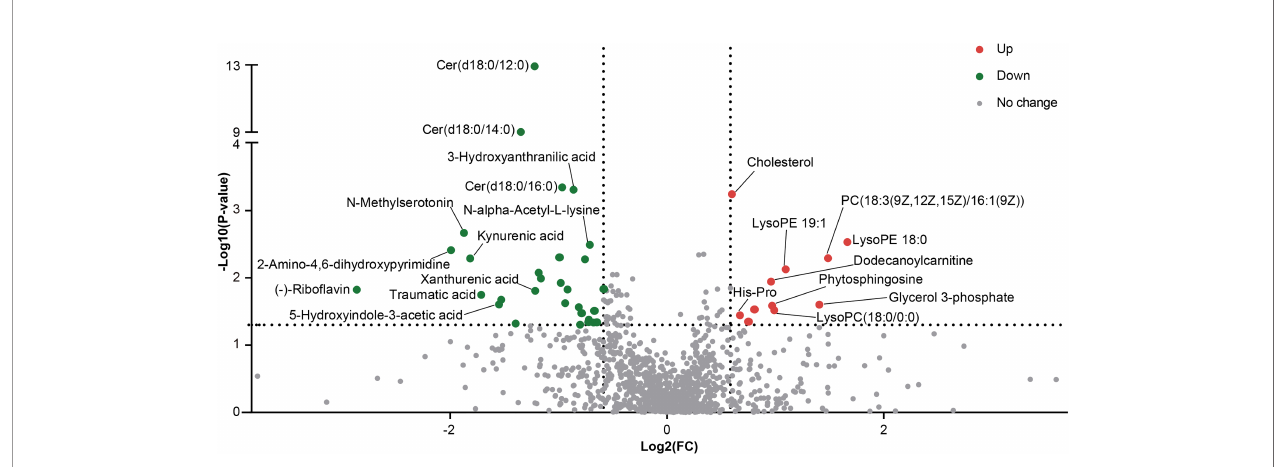
FIGURE 5 | The volcano plot showed the differentially altered metabolites between the two